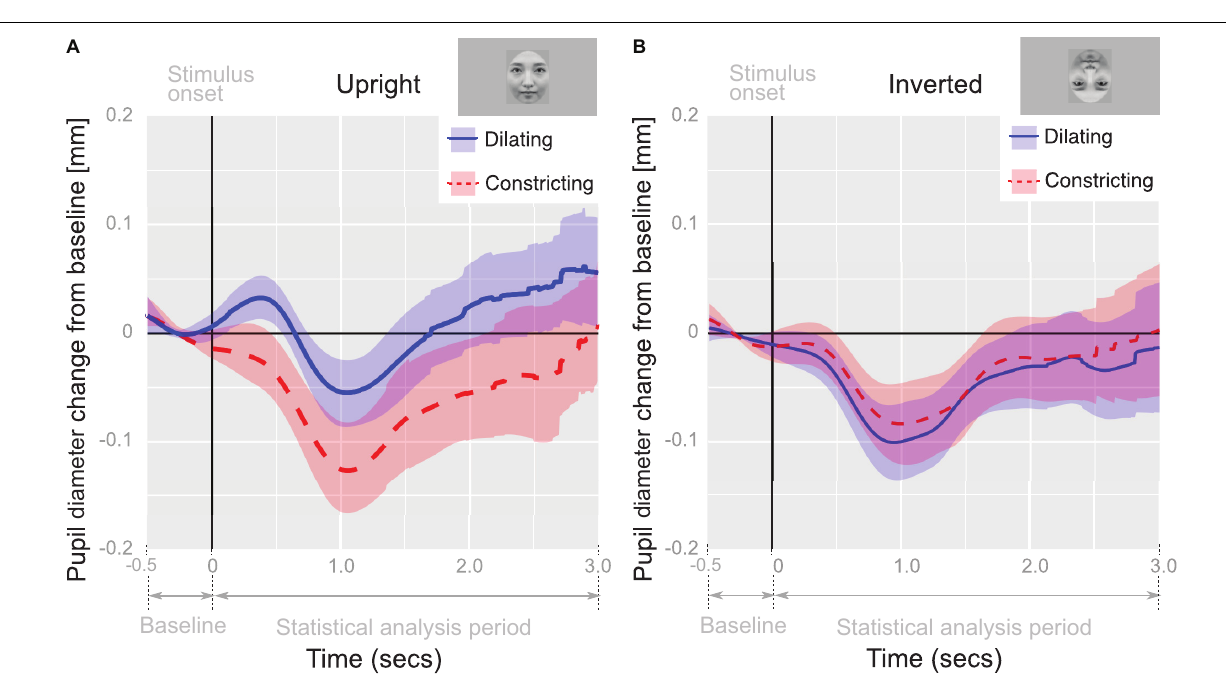
FIGURE 3 | Pupil-diameter change from baseline. Recorded diameter of pupils over time while viewing pupil-diameter dilating or constricting (0–3 s) adjusted for baseline pupil diameter during fixation cross viewing (–0.5–0 s); The time course of the average change of pupil-diameter in panel (A) upright and (B) inverted face condition. Shaded regions indicate 95% confidence